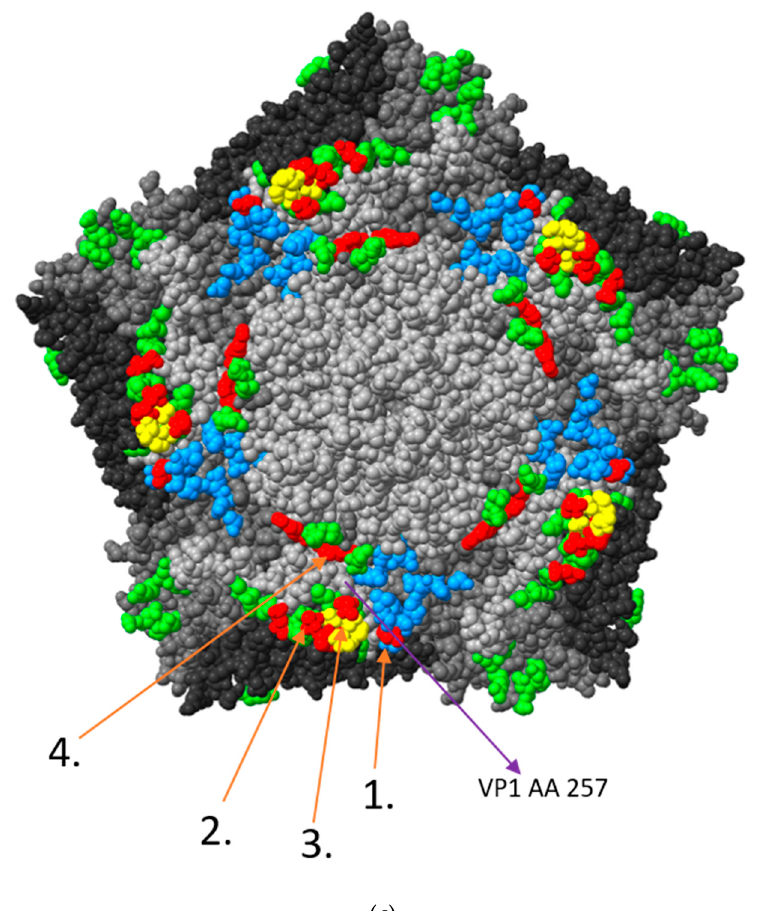
Figure 9. ( a ) 3D model of CVB1 virus pentameric structure displayed in ChimeraX from TP2. One pentamer consists of five protomers, each constructed by viral proteins VP1-4. Blue indicates mutation in one strain; yellow, mutations in 2–3 strains; orange, mutations in 4–5 strains; purple, mutations in 6 strains; and red, mutations (K257R) in the AA in all PIDVs. ( b ) 3D model of CVB1 with CAR binding site marked with blue color and DAF binding site with green color, shared AAs are marked with yellow color. ( c ) Mutations in CAR and DAF binding site are marked with red. Number 1. is mutation on AA202 in VP1 shared by three PIDVs, number 2. is mutation on AA 162 in VP2 shared by five PIDVs, number 3. is mutation on AA 165 in VP2 shared by three PIDVs and number 4. is AA 237 in VP3 shared by three PIDVs. AA257 in VP1, which has K257R mutation found in all studied PIDV strains, is also indicated.